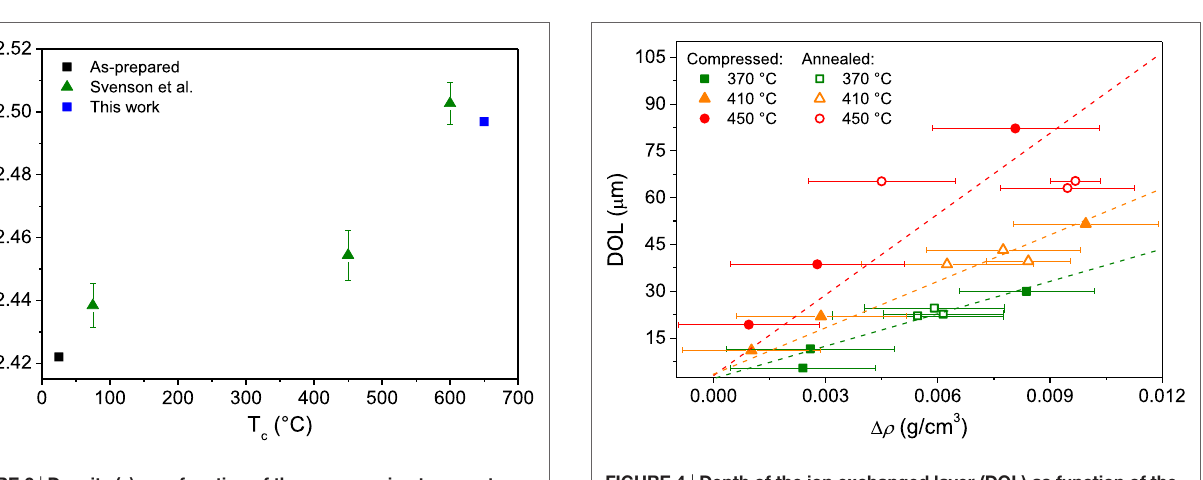
FigUre 2 | Density ( ρ ) as a function of the compression temperature ( T c ) at 1 gPa . The as-prepared sample has not been compressed or ion exchanged, whereas the other samples have all been ion exchanged at 410°C for 10 h after the isostatic compression. Data are included from Svenson et al.